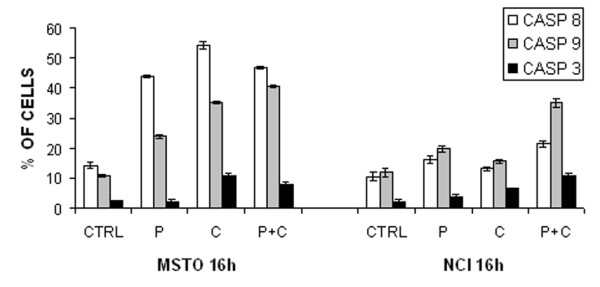
Determination of enzymatic activity of the caspase (CASP) 3, 8 and 9. Following 16 h treatments with piroxicam and/or CDDP as indicated, the activity of caspase 3, 8 and 9 was measured and expressed as percentage ± Standard deviation of total cells. Experiments were performed in triplicate. CTRL = control; P = piroxicam; C = CDDP.